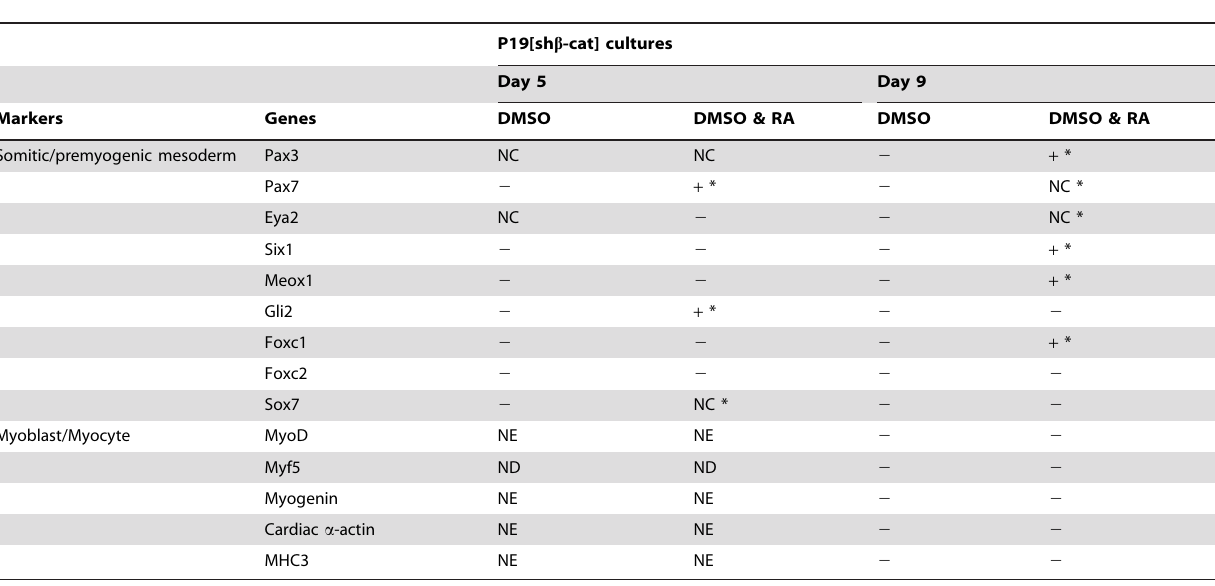
Successful isolation of cytoplasmic and nuclear protein fractions was confirmed by a -tubulin and RNA polymerase II immunoblots. The nuclear fractions were found to contain , 20% of cytoplasmic protein (data not shown). Table 2. Summary of changes in gene expression in P19[sh b -cat] cultures compared to same-day P19[shControl] cultures after differentiation in DMSO, with and without RA ( 2 =decrease; + =increase; NC= No change; NE =not expressed; ND =not determined; *=Enhanced or recovered gene expression due to RA treatment)(Data from Figs. 3 and